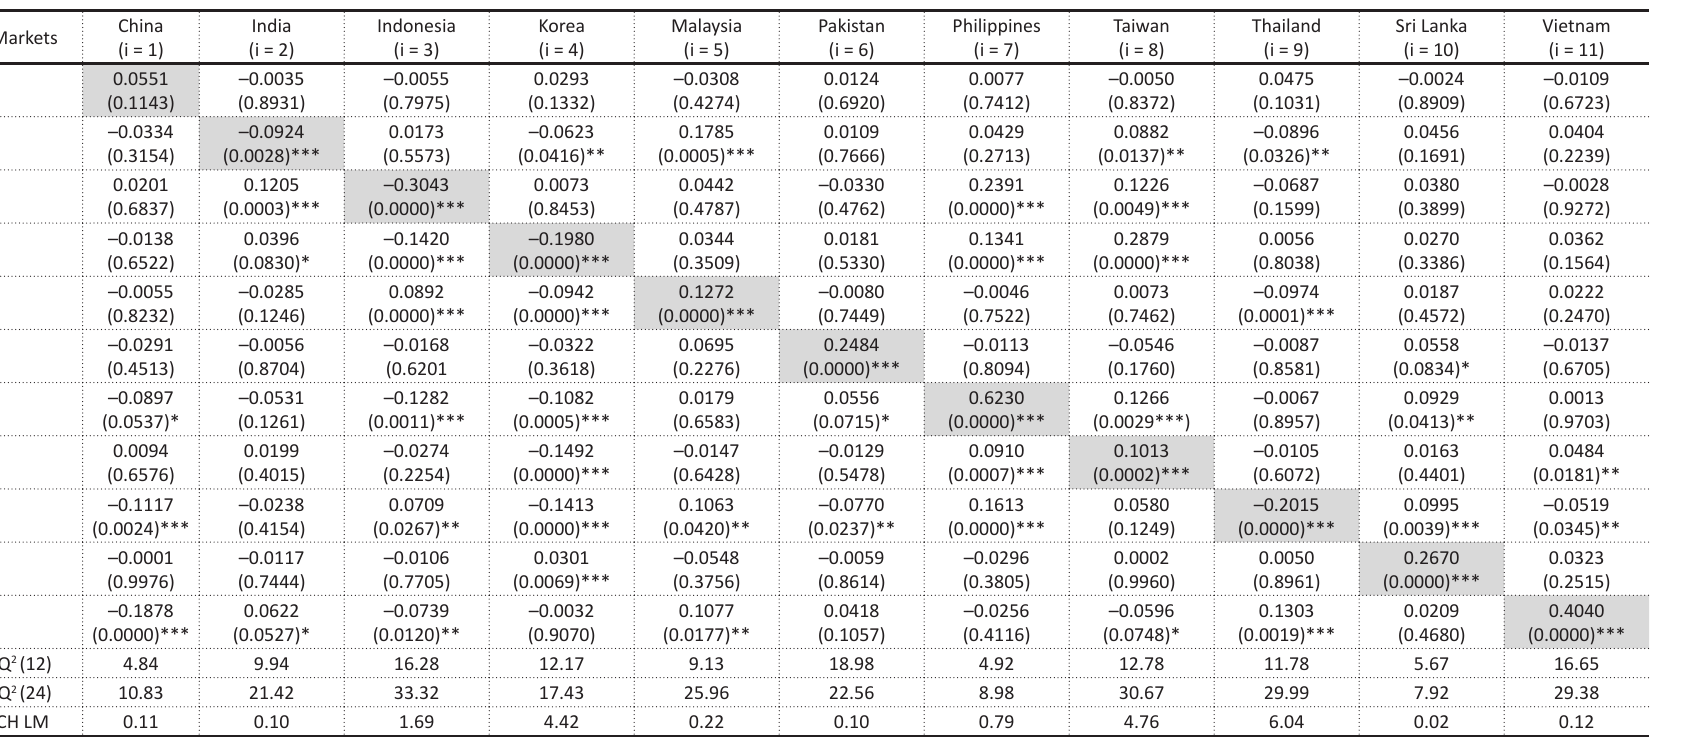
Table 5. Asymmetric transmission during pre-global financial